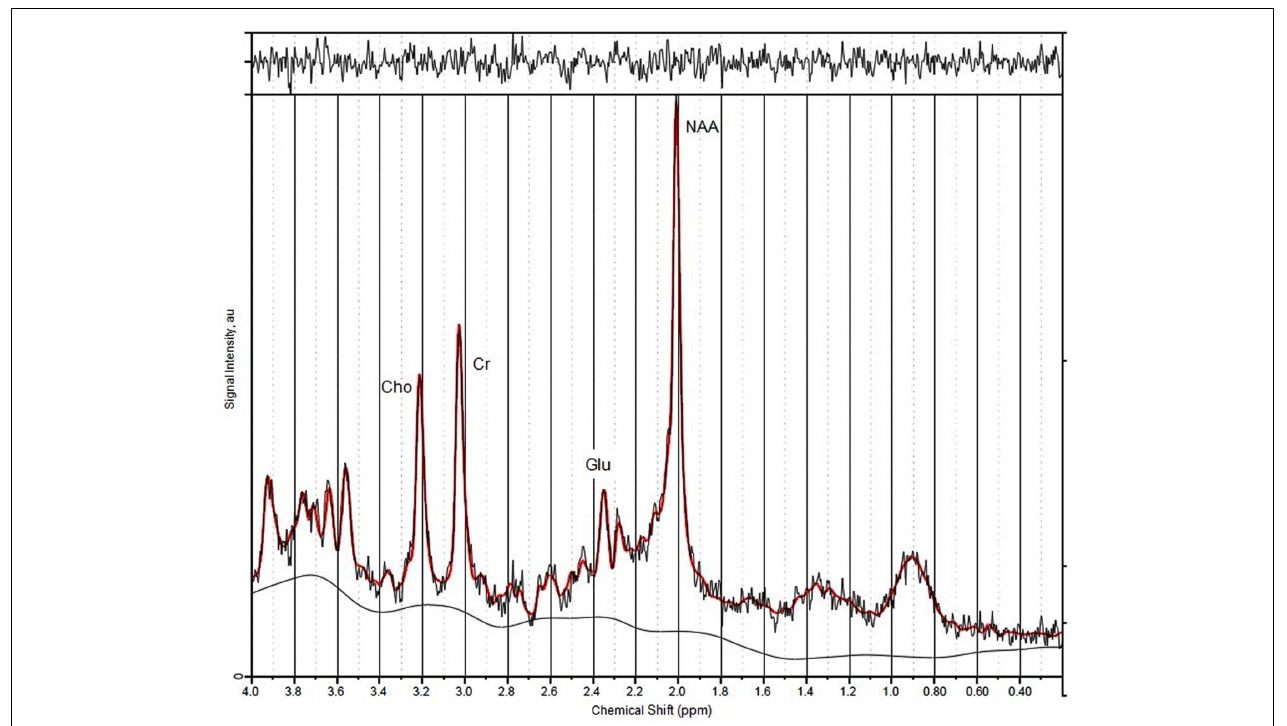
FIGURE 2 |A representative spectrum indicating position of peaks and calculation of signal-to-noise ratios.